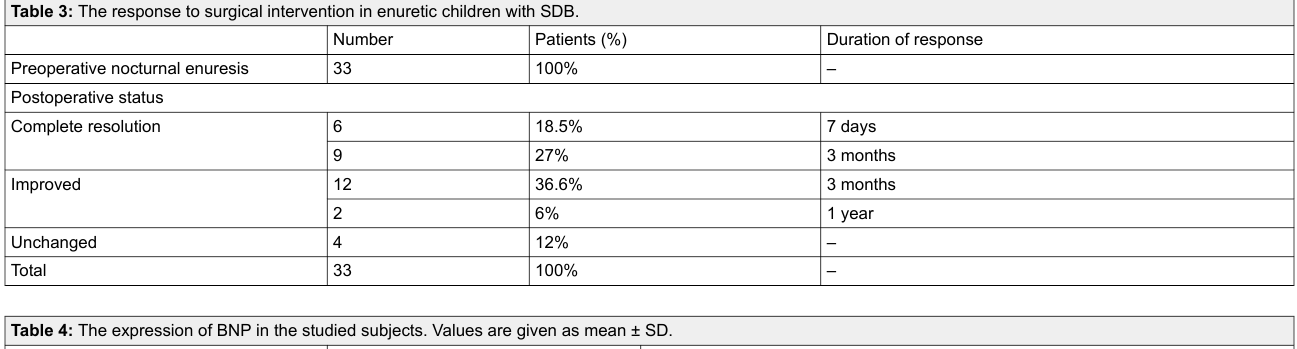
Table 3: The response to surgical intervention in enuretic children with SDB.